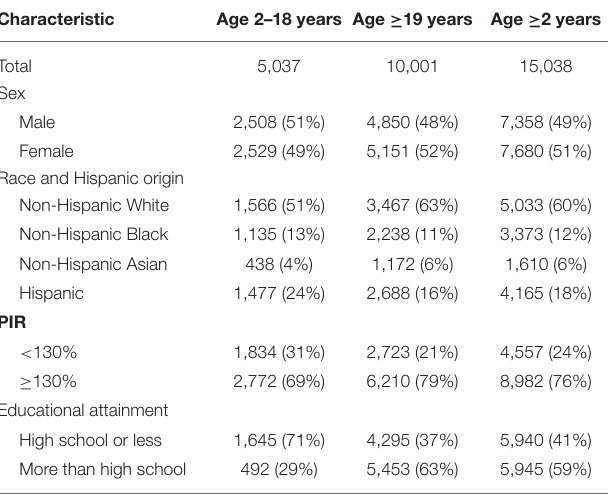
TABLE 1 | Demographic characteristics of individuals from a representative sample of the US population.